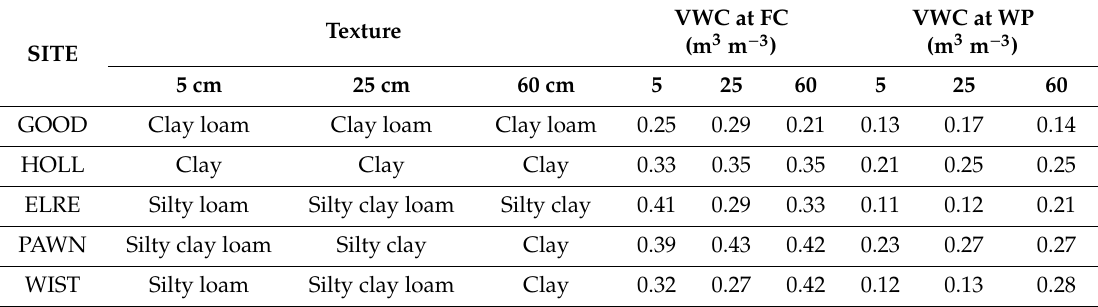
Table 2. Soil texture and volumetric water content (VWC) (m 3 m − 3 ) at field capacity (FC) and wilting point (WP) thresholds for the three sensor installation depths of 5, 25, and 60 cm at each study